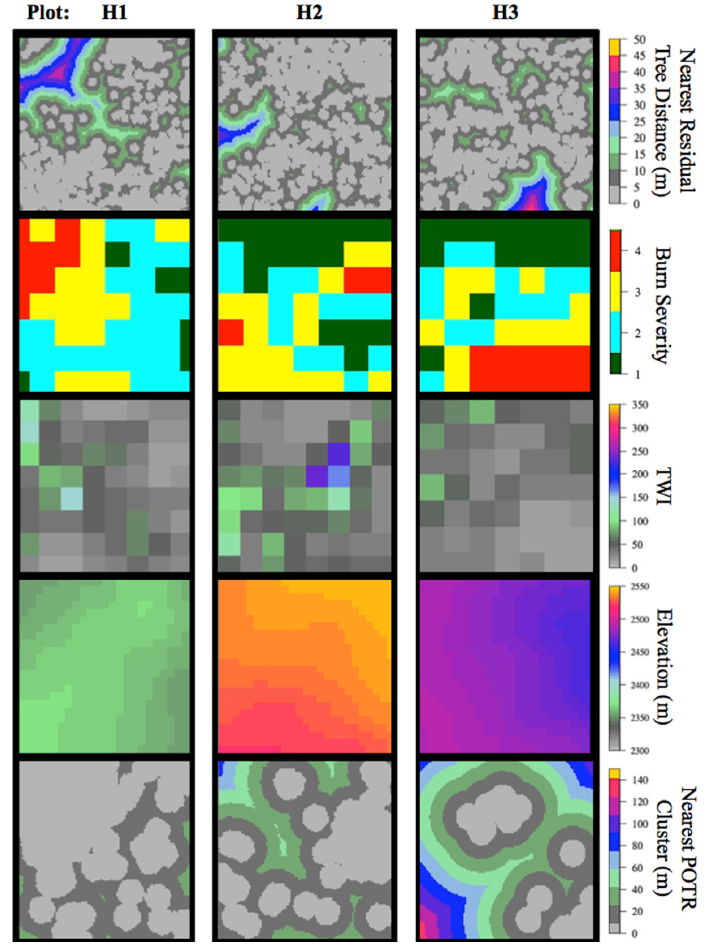
Figure 6. Significant drivers of post ‐ fire regeneration density for the Hayman Fire plots (H1, H2, and H3) include nearest residual tree distance (m), burn severity, topographic wetness index (TWI), elevation, and the nearest aspen (POTR) cluster. Thematic burn severity classes include unburned (green), low ‐ (cyan), moderate ‐ (yellow), and high ‐ (red) severity. Table 4. Estimates of regeneration density (stems m − 2 ) regression coefficients, standard errors (S.E.) and p ‐ values for the Hayman Fire plot level point pattern models. The distance to the nearest residual tree, burn severity, topographic wetness index (TWI), elevation, and the distance to the nearest aspen (POTR) cluster were important drivers of post ‐ fire regeneration density.